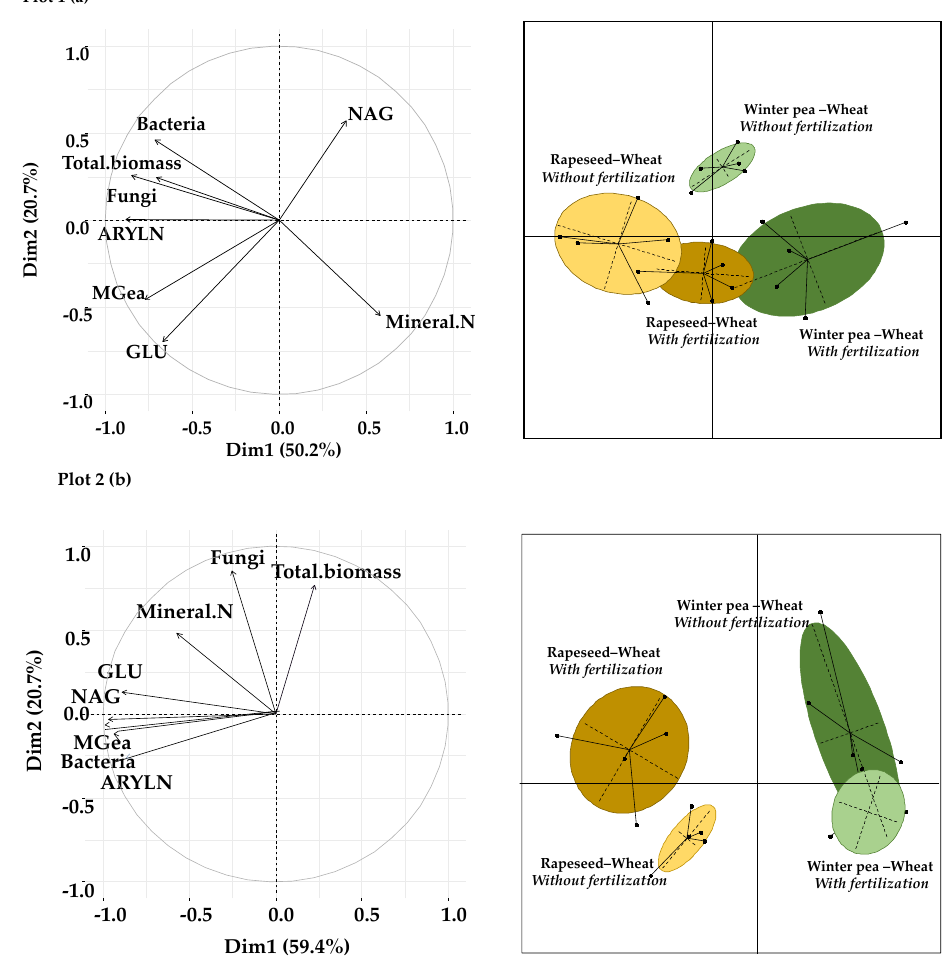
Figure 6. Principal component analysis of microbial abundance and enzyme activities and mineral N content in the two studied plots: ( a ) plot 1, ( b ) plot 2. GLU: β -D-glucosidase, NAG: N-acetyl- β -glucosaminidase, ARYLN: arylamidase, MGea: geometric means.